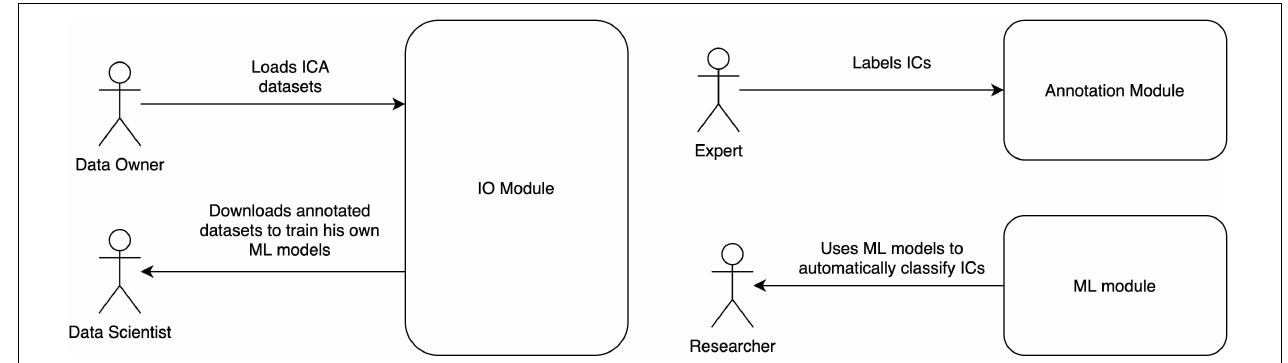
FIGURE 1 | ALICE toolbox high-level architecture and user roles. Annotation module UI serves for Data Owners to upload IC data to the database and for Experts to provide annotation on existing or newly uploaded data. Data Scientists and Researchers work with ML module: the former train models based on selected samples from the database, the latter take pretrained models to work with their own data (online or offline). Online version of the ALICE toolbox is available at